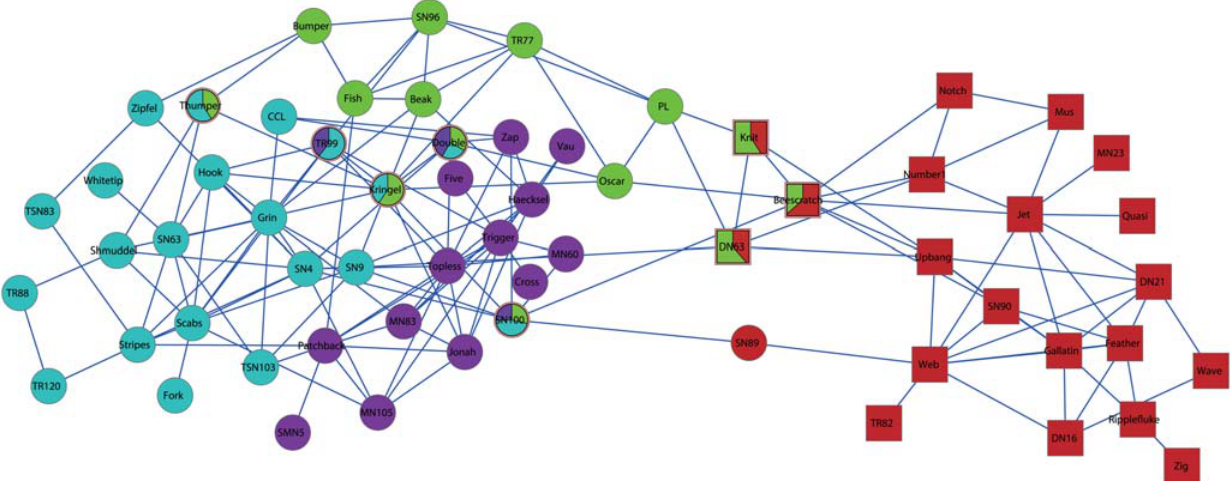
Fig 9. The mean entropy of membership distribution when K = 2. X-axis indicates the index of each vertex, and the Y-axis indicates the mean entropy of membership distribution when K = 2.